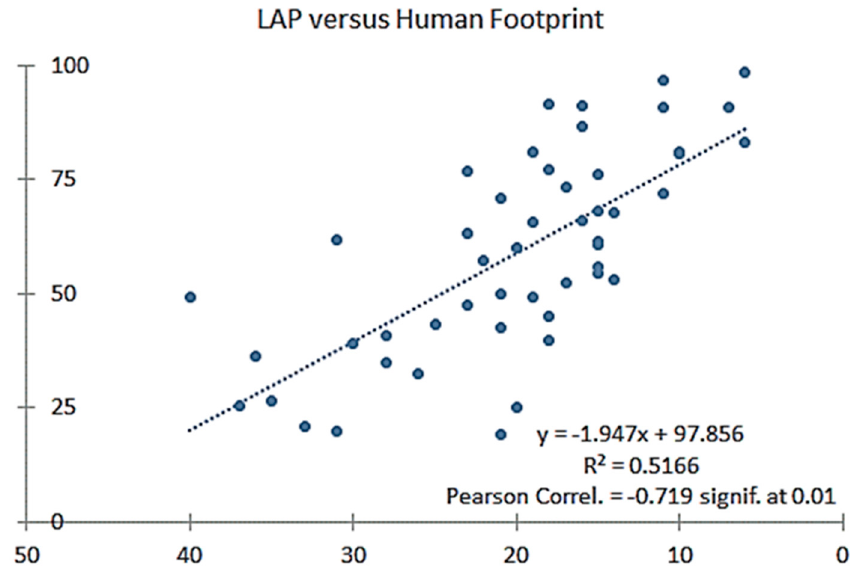
Figure 8. Correlation between the two indices, LAP score on Y-Axis and Human Footprint (HFP) on X-Axis. Note that the score gradient is reversed in the two indices: LAP scores of “0” mean degraded landscapes and “100” mean excellent ones; in the HFP, “0” stands for excellent (no impact) and “50” for the most degraded. Pearson correlation calculates the effect of change in one variable when the other variable changes, from moderately to well correlated in this case.